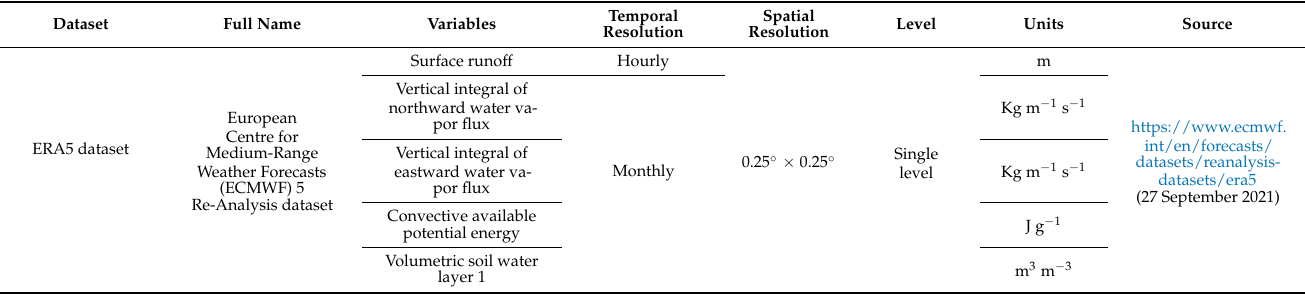
Figure 1. Spatial distributions of global streamflow data with record lengths in years during 1979–2012: In ( a ), flood peaks are available in these stations. In ( b ), daily streamflow observa- tions are available, and the streamflow stations in South Asia are not shown due to lacking daily streamflow in this region. Table 2. Details of datasets for reanalysis variables used in this